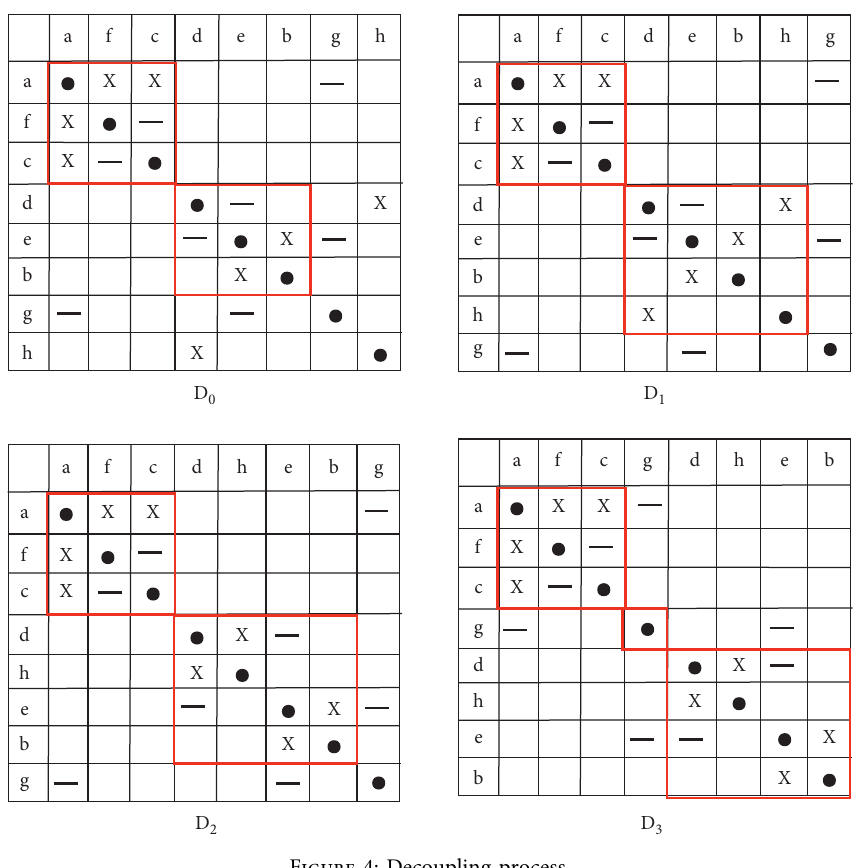
Figure 4: Decoupling